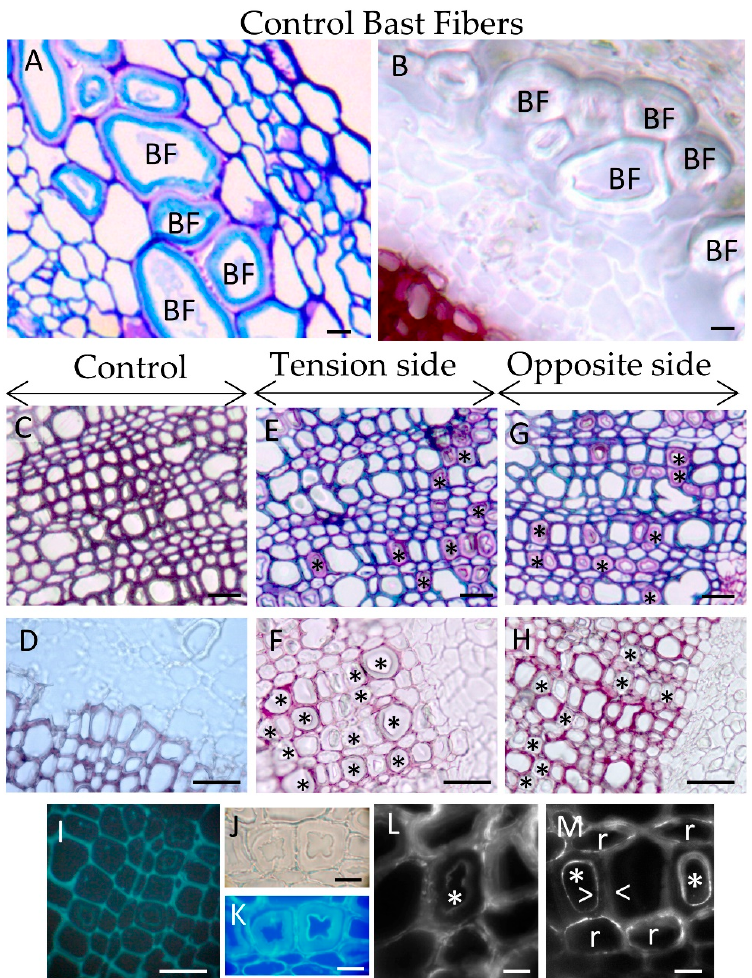
Figure 1. Comparison between bast fibers and xylem G-layers induced in tilted flax. ( A , B ) Control bast fibers (BF). No lignin is detected within BF cell wall or in cell junctions. ( C , D ) Control wood. ( E , F ) Xylem G-layer in tension side (* G-layer). It appears in grouped fiber-tracheids and rarely in ray cells. No G-layer was noticed in large vessels. ( G , H ) Xylem G-layer in the opposite side (* G layer). ( I ) Photonic epifluorescence only shows weak autofluorescence in the innermost part of G-layer, tension wood. ( J , K ) The cellulosic nature of G-layer is confirmed with calcofluor white. ( L ) Arabinan residues (labeled with LM6 antibodies) were particularly detected in the autofluorescent layer (*) (see G ) as well as raft-shape within ray cells. ( M ) Xylan residues (labeled with LM10 antibodies) were present as dotted spots or layered-rafts both in fiber-tracheids or ray cells (r). Weak signal is detected in the autofluorescent layer of G-layer (*, white arrowheads). Semi thin section (5 µ m thickness). ( A , C , E , G ): TBO staining, ( B , D , F , H ): phloroglucinol/HCl staining (Wiesner reaction). ( A – H ) bar